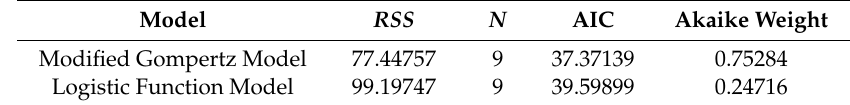
Figure 5. Logistic Function model fitting for experimental data.